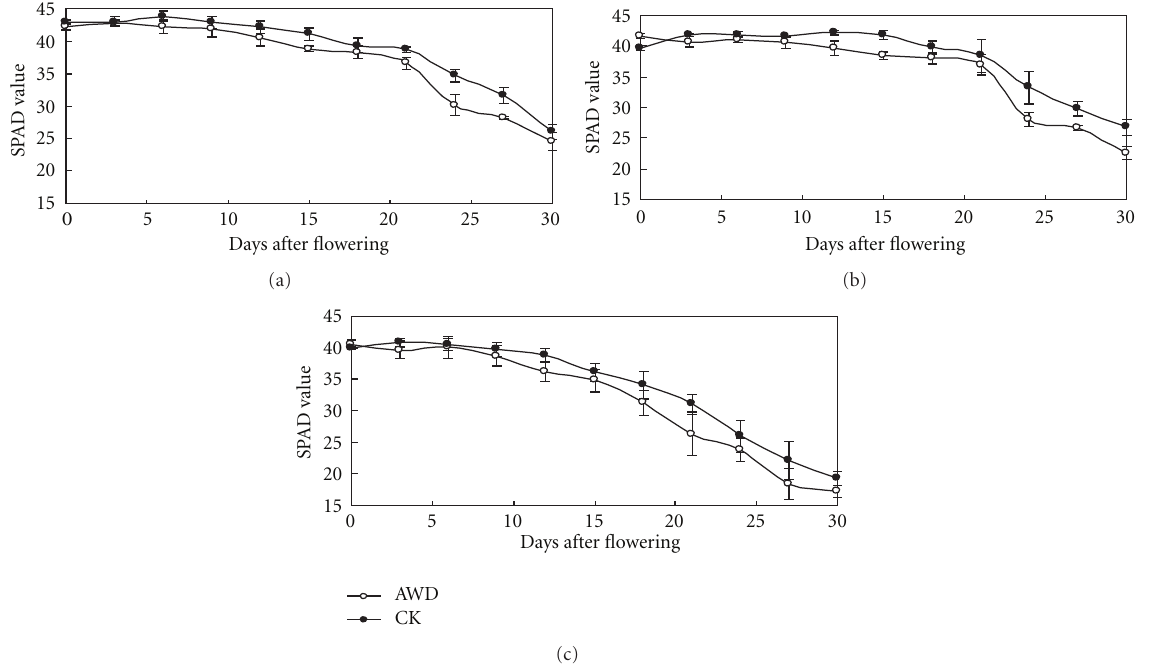
Figure 3: SPAD values after flowering under AWD and CF in 2010 DS at the IRRI farm. Three varieties IR72 (a), IR82372H (b), and SL-8H (c) were used in the experiment at high N level.